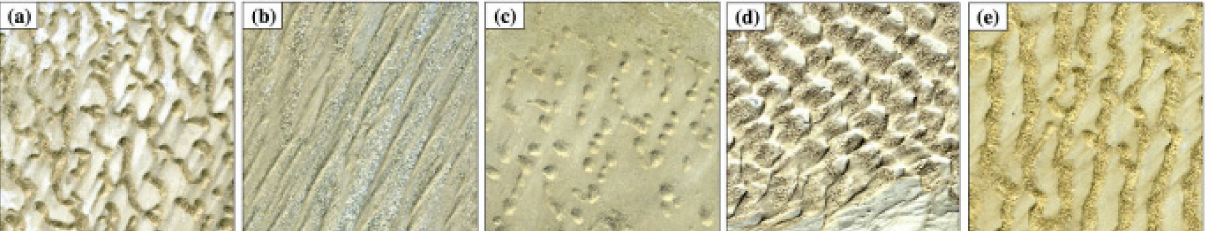
Figure 12. Geomorphic structural diversity, monitored with remote sensing technology. Examples of dune-field landscape patterns on remotely sensed data. ( a ) Barchan dunes, ( b ) linear dunes, ( c ) dome dunes, ( d ) reticulate dunes, and ( e ) longitudinal dunes (reprinted with permission from Zeng et al. [117], 2021, Elsevier. license no.